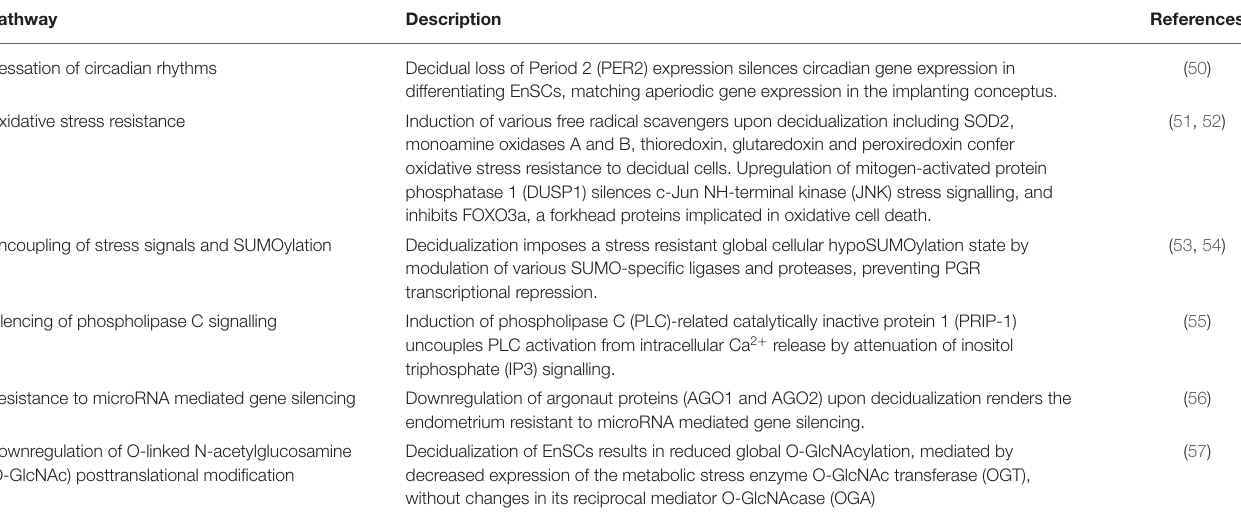
TABLE 1 | Mechanisms of DeC cellular defence and stress-resistance.